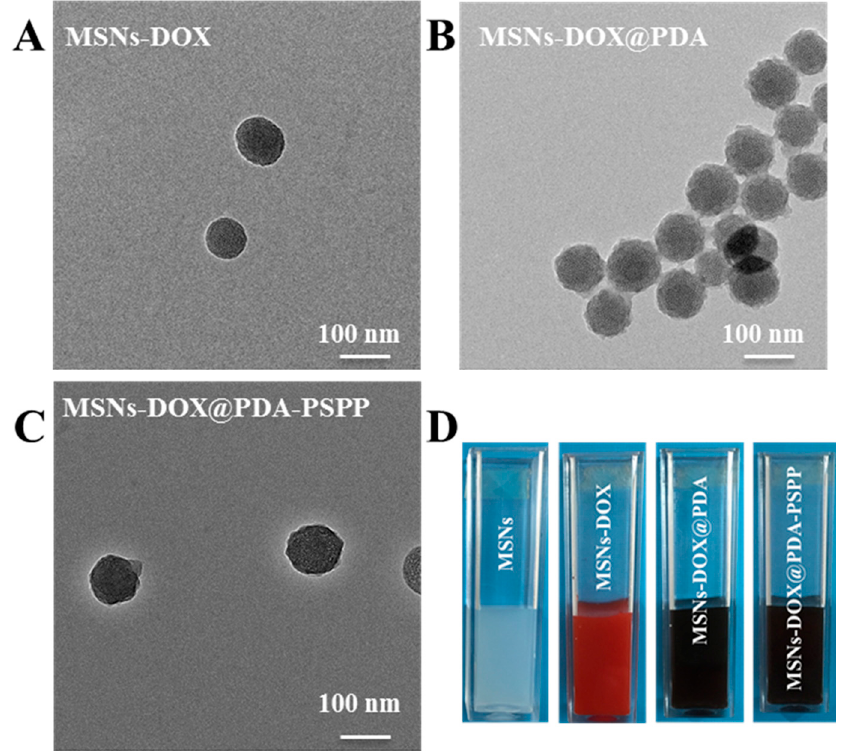
Figure 6. The TEM images of ( A ) MSNs-DOX; ( B ) MSNs-DOX@PDA and ( C ) MSNs-DOX@PDA-PSPP; ( D ) The digital photos of MSNs, MSNs-DOX, MSNs-DOX@PDA and MSNs-DOX@PDA-PSPP